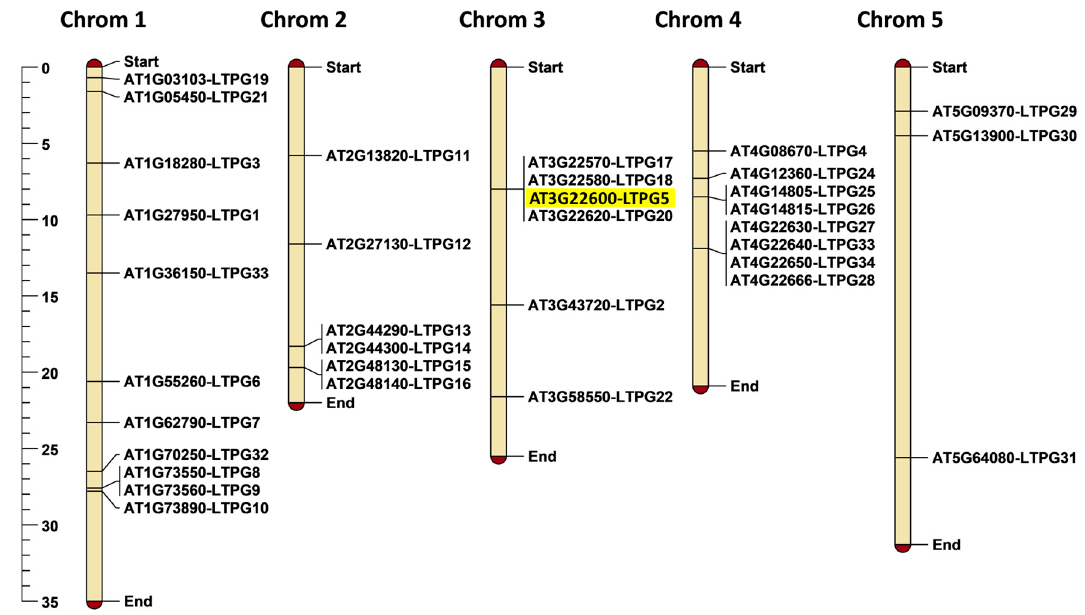
Figure 1. Chromosomal positioning of 34 LTPg genes on Arabidopsis chromosomes. The scale on the left side of the figure shows chromosomal length in mega base pairs (Mbp).